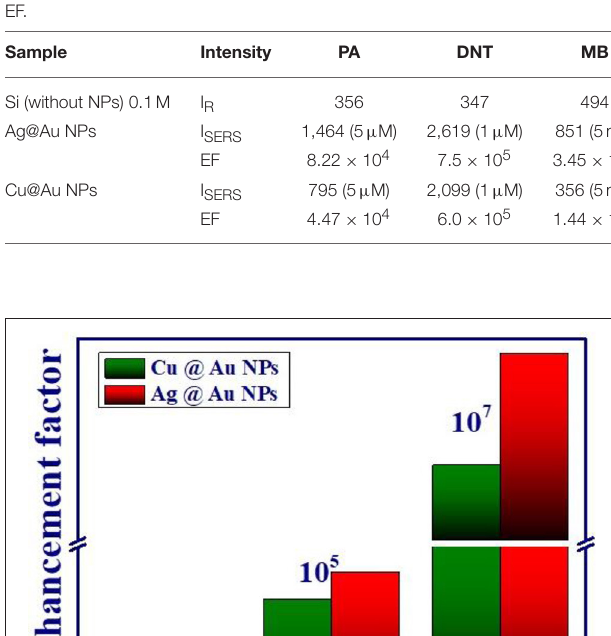
drop casting more number of NPs of same type or of different metals (b) drop casting these NPs in nanostructured metals or even Si/SiO 2 and subsequently perform the SERS